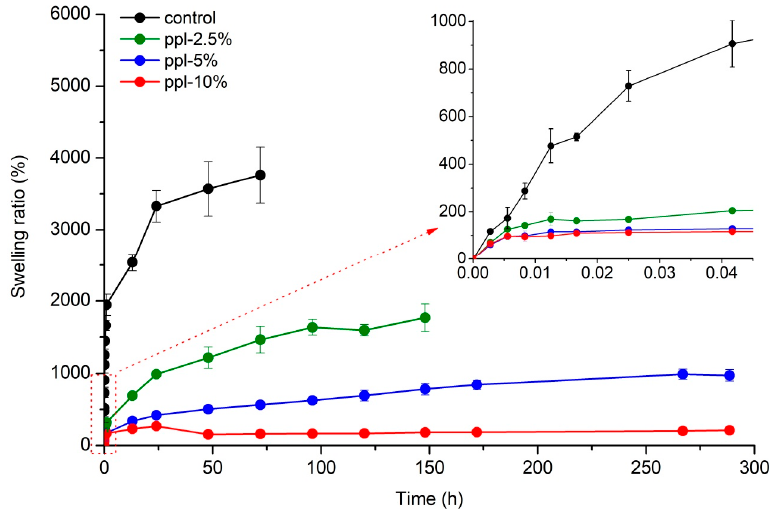
Figure 5. Swelling properties of the developed films.